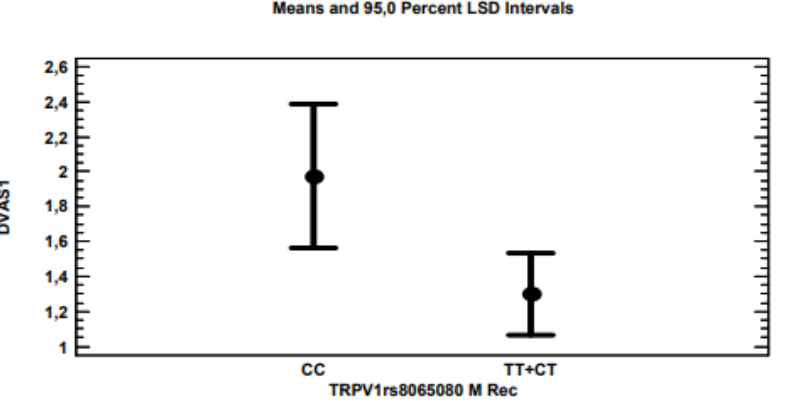
Figure 3. TRPV1 CC homozygous patients for the TRPV1 gene obtained an average pain decrease of 2 VAS points, compared to the 1.3 VAS points of TT homozygotes or CT heterozygotes.